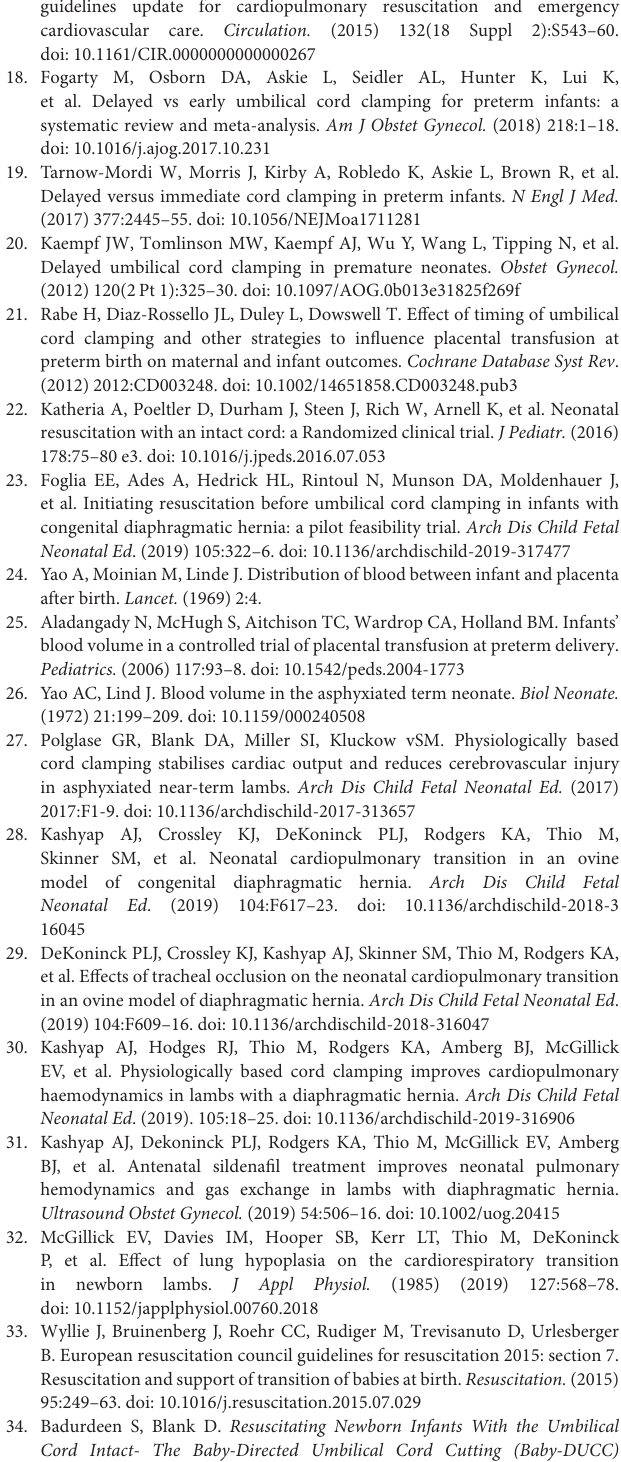
Supplementary Figure 2 | Temperature from the start of the experiment in lambs that received immediate cord clamping (ICC) vs. physiologic-based cord clamping (PBCC) displayed in mean ± SD using two-way mixed ANOVA with